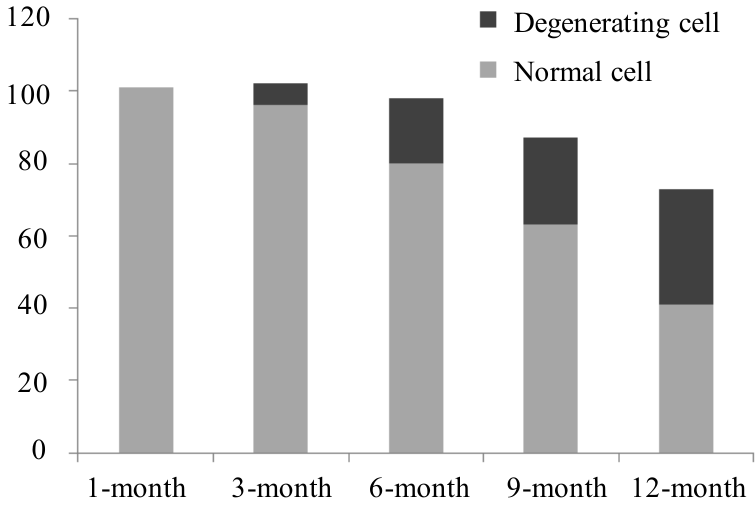
Figure 6. Number of normal and degenerating chondrocyte in each age